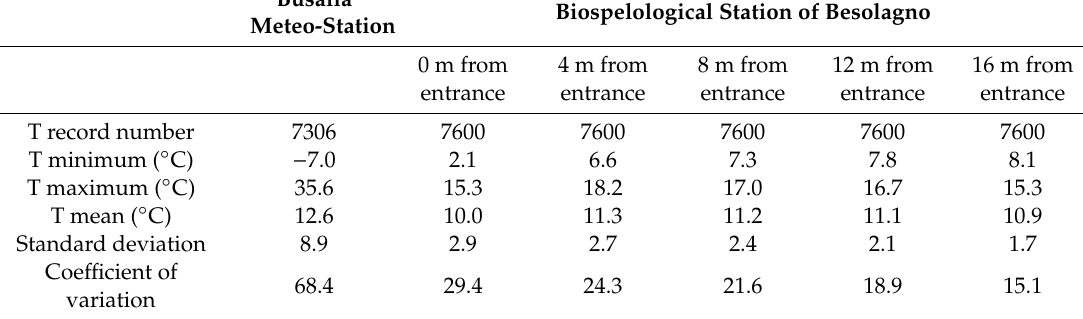
Figure 1. Air temperatures recorded inside and outside the “Biospeleological Station of San Bartolomeo”. Busalla refers to the meteo-station of Busalla (Province of Genova). The recording period was October 12, 2002 – October 11, 2003. The data-loggers used were Hanna Instruments HI 140. 0 m = cave entrance; 4, 8, 12, and 16 are meters from the cave entrance. Table 1. Number of temperature records, minimum, maximum, mean, standard deviation and coefficient of variation of the annual temperatures recorded outside and inside the study site of the “Biospeleological Station of San Bartolomeo”, from October 2002 to October 2003. Table modified from reference [23].